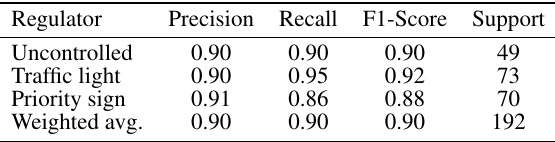
Table 3. Results of the arm rule detection.